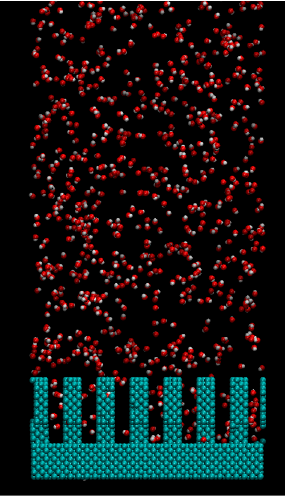
Figure 4. Snapshot of water vapor and nanostructure prepared as the initial condition of the condensation simulation. Table 1. The parameters of ε in the calculation. The ε = 19.74 kJ/mol is the case of copper. Ratio